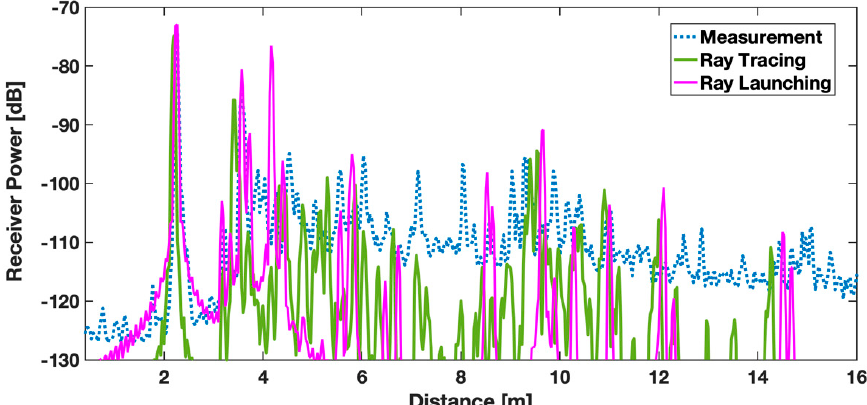
Figure 6. Comparison between the PDP measured at Position 18, simulated with the tracer and simulated with the launcher programmed in GPU.